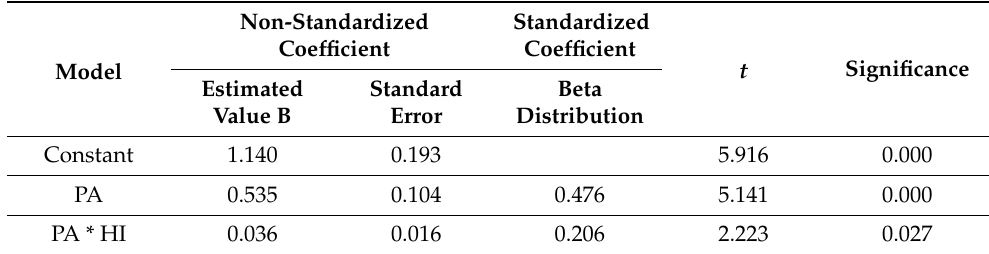
Table 6. Analysis of the interference effect of healthy image on place attachment and